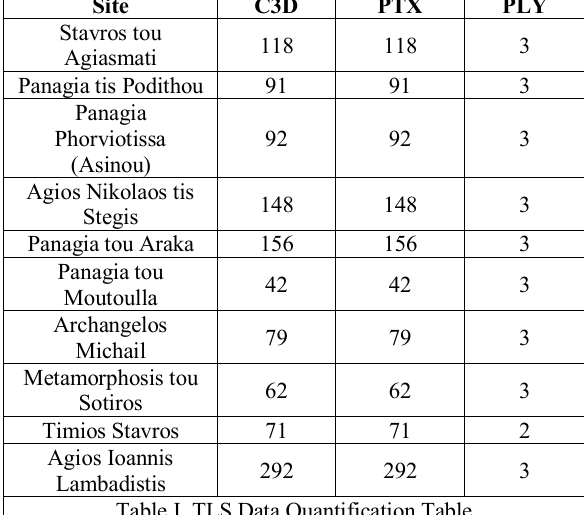
Table I. TLS Data Quantification Table